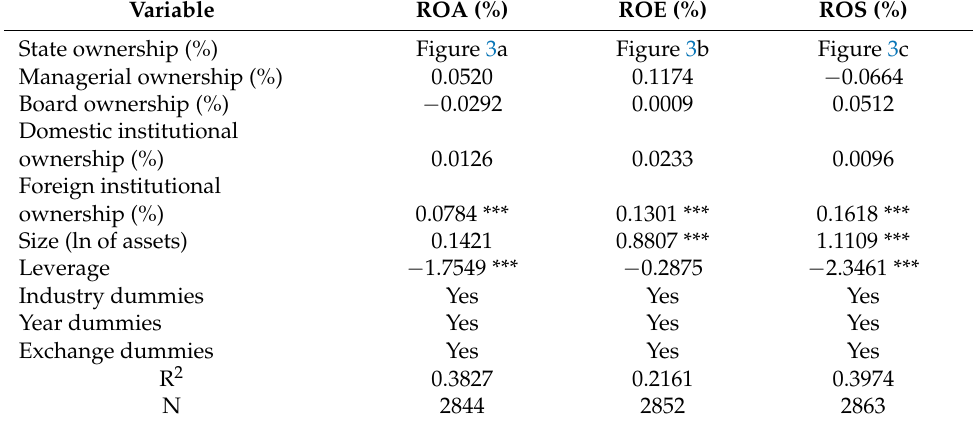
Table 4. IV semiparametric regression models of partially privatized firm profitability on residual state